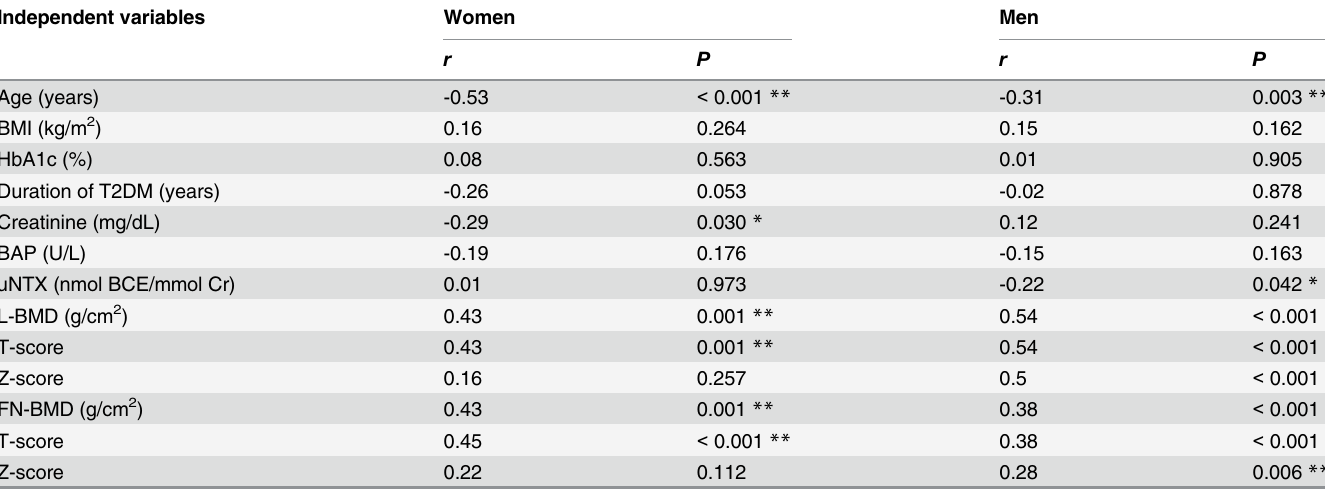
Table 2. Simple regression analysis between the vertebral strength index and the independent variables. Independent variables